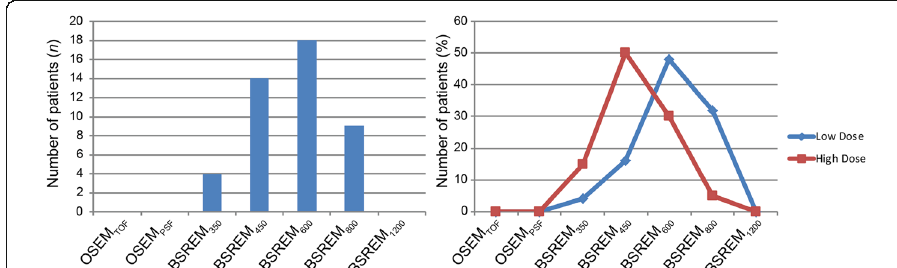
Fig. 1 Absolute frequency distribution of preferred reconstruction algorithms for lung cancer assessment as rated by the readers, including the ratings for all study subjects ( a ): BSREM 600 was chosen most frequently as the preferred reconstruction algorithm by the readers, followed by BSREM 450 , BSREM 800 , and BSREM 350 . When comparing the relative frequency distribution of preferred reconstruction algorithms ( b ) for high-18F-FDG-dosage regimen (>2.0 MBq/kg body weight; n =20 patients) and low-dosage regimen ( ≤ 2.0 MBq/kg body weight; n =25